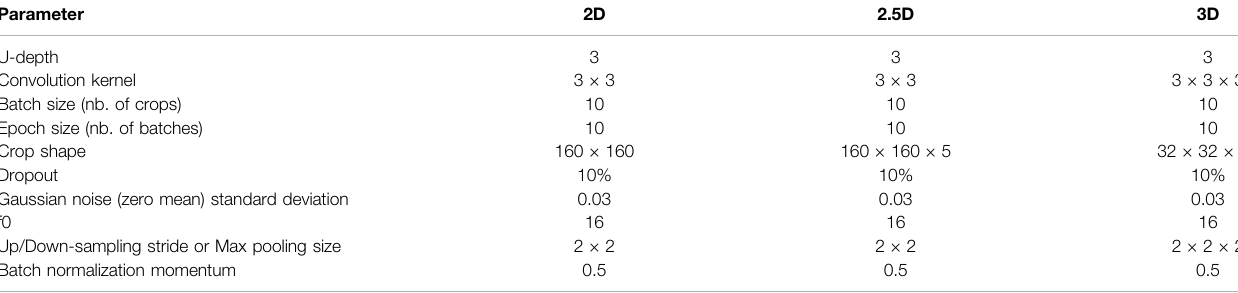
TABLE 1 | Default hyperparameters. Parameters not mentioned are the default in TensorFlow 2.2.0. Parameter U-depth